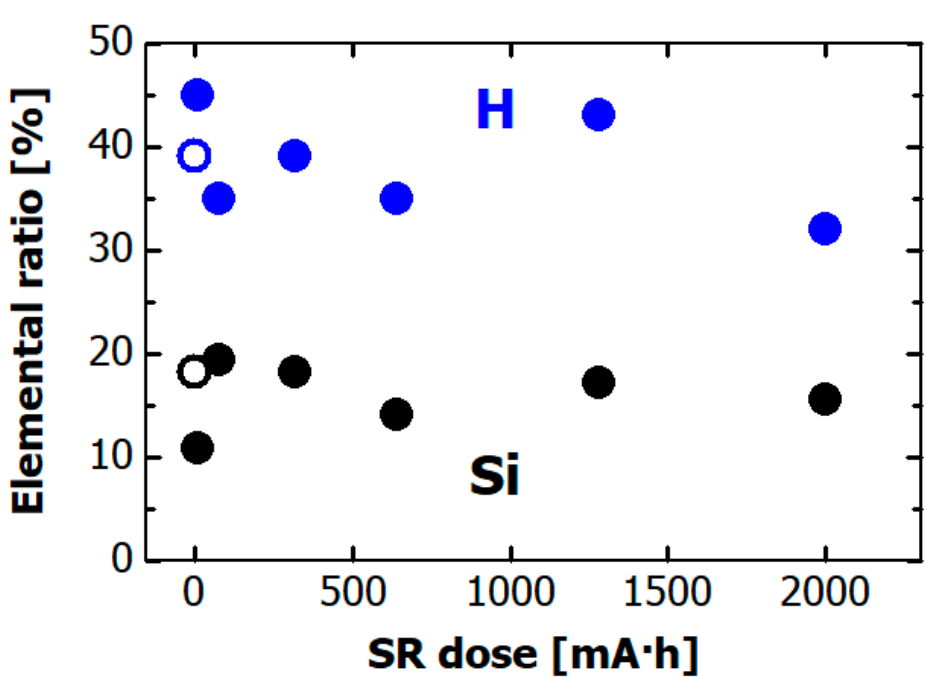
Figure 6. Dependence on SR dose of elemental composition ratio in hydrogenated Si-DLC film, as estimated by ERDA and RBS. Blue and black circles respectively indicate hydrogen and silicon ratios. The open circle indicates hydrogen and silicon ratios before the SR irradiation.